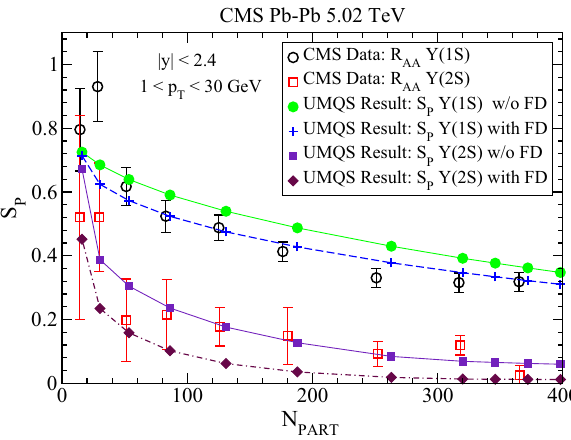
Fig. 15 The p T integrated survival probability of ϒ( nS ) is compared withthemeasured R AA versuscentralityinPb–Pbcollisionsat √ 5 . 02 TeV [90] in p T range: 1 < p T < 30 GeV s NN = 2 . 76 values of double ratio in Pb–Pb collision at